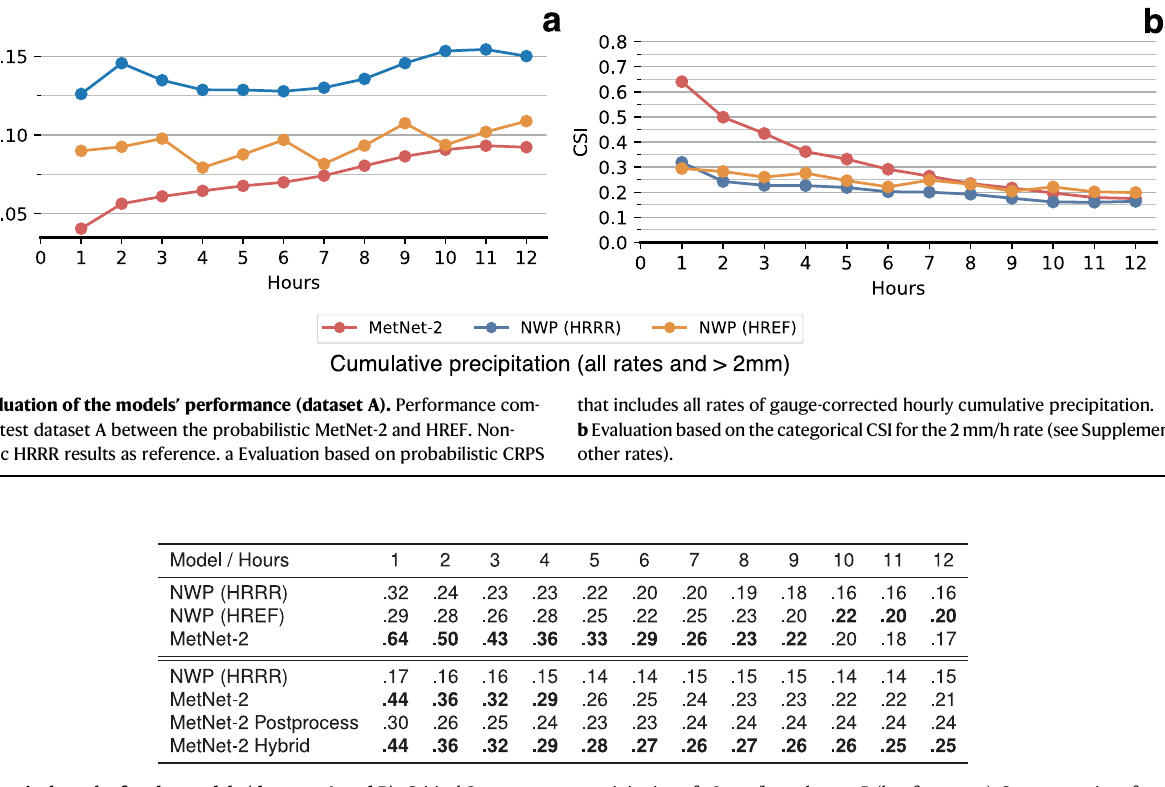
precipitation of ≥ 2mm/h on dataset B(last four rows).Scores are given foreachof the 12h of lead time. The best score for each set of results and each lead time is high-lighted in